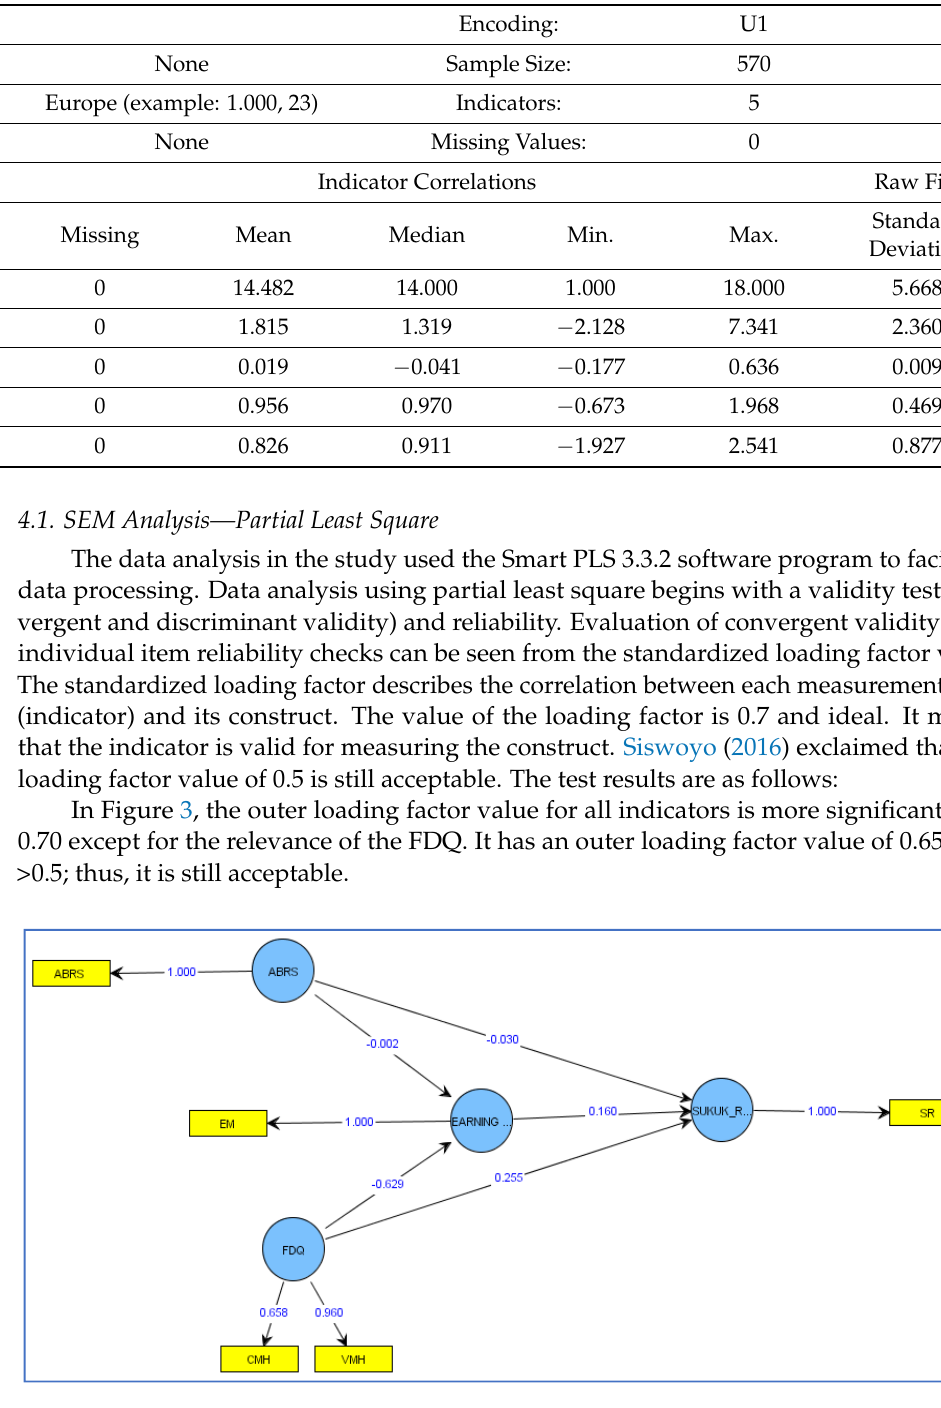
Table 3. Descriptive Analysis.